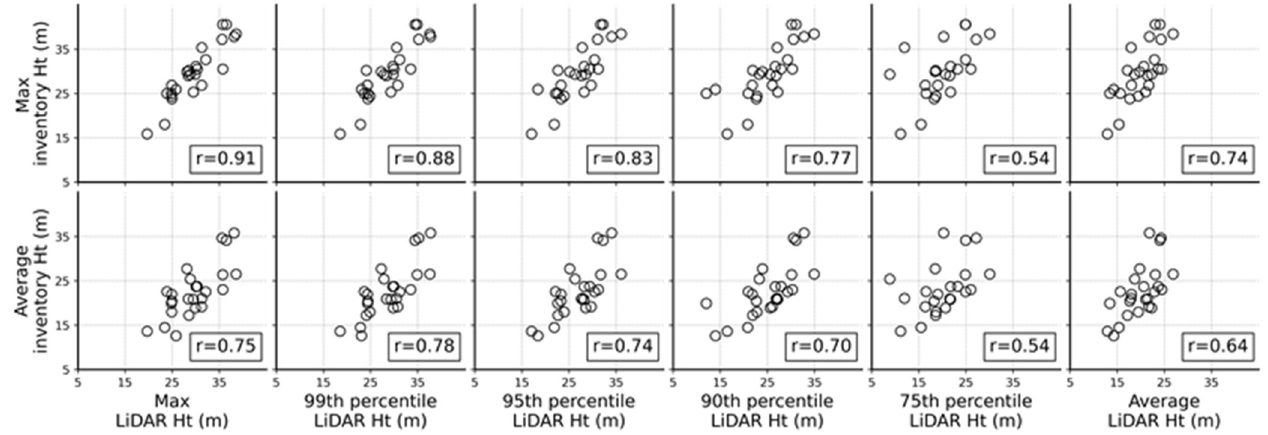
Figure 9. Correlation between LiDAR and inventory height metrics. LiDAR data in 2011–2013 and inventory data in 2008–2012 were used. Forest plots have positional uncertainty approximately less than 0.1 m ( n = 25). Ht: height.